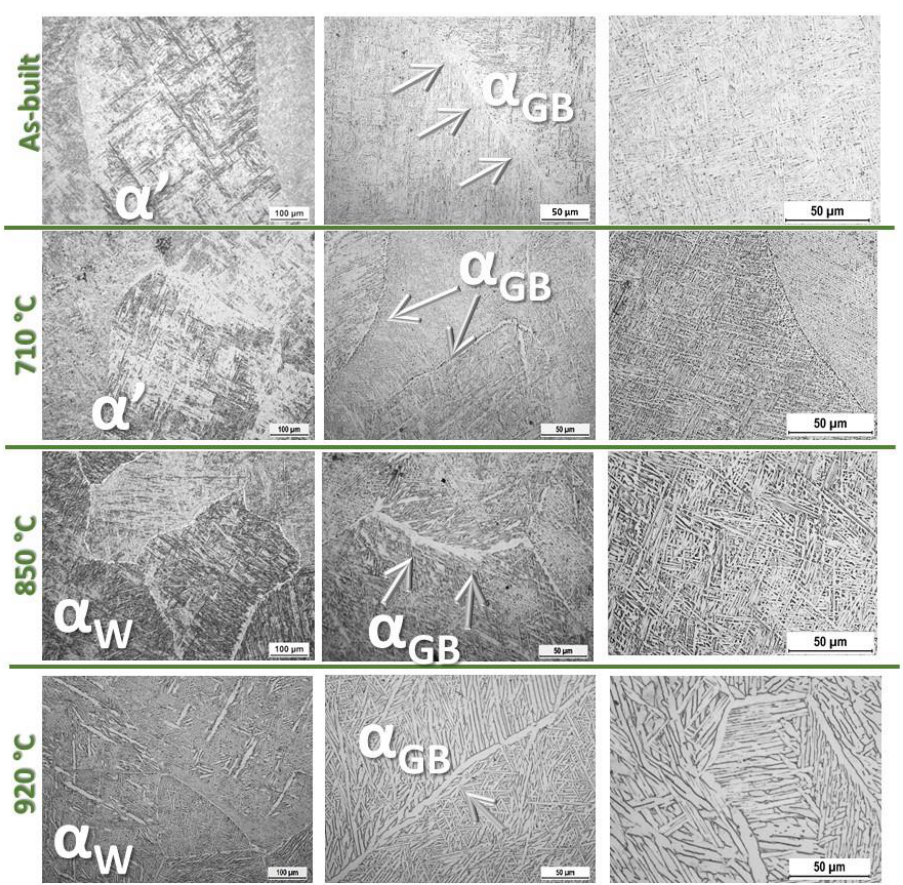
Figure 15. Evolution of the microstructures in the as-built state and after the application of the three different thermal treatments. In the columns, microstructures at different magnifications are shown (α’: martensite, α W : Widmanstätten α phase, α GB : α phase in the grain boundary).